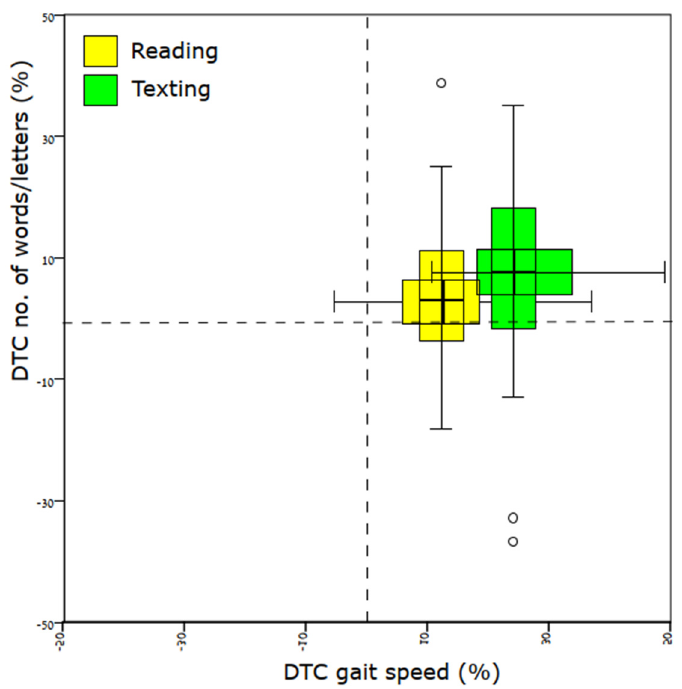
Figure 1. Box plots of dual-task costs (DTCs) for one aspect of performance of the mobile phone task (reading or texting speed) on the ordinate and performance of the walking task (gait speed) on the abscissa. Positive values denote worse performance for both tasks. Results indicate that texting (green) compared with reading (yellow) during walking incurs higher DTCs for both tasks.